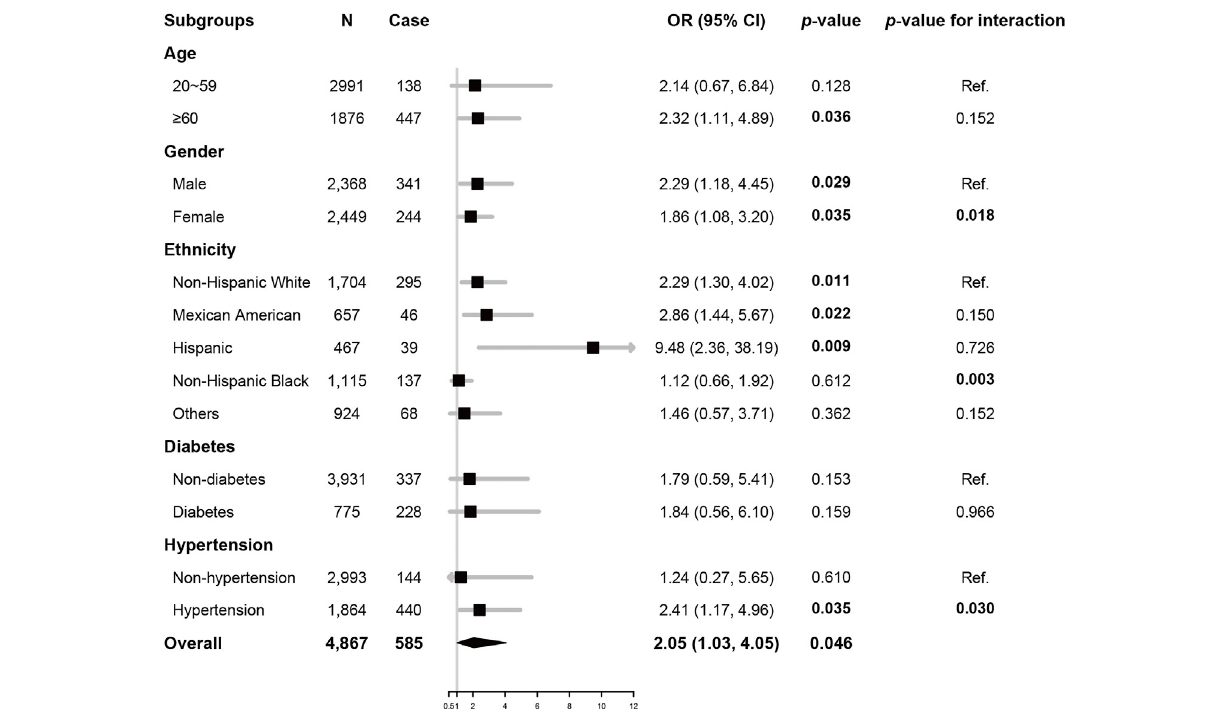
Frontiers in Cell and Developmental Biology |